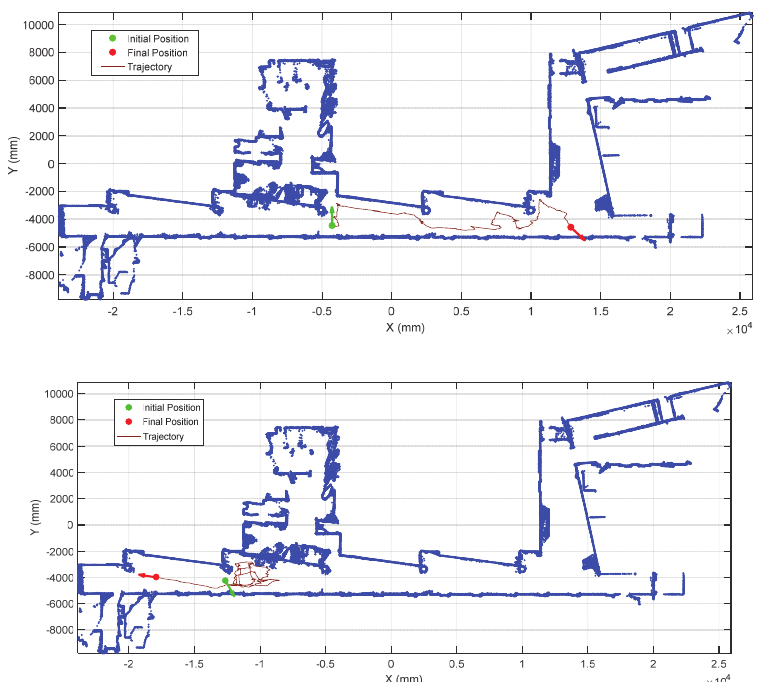
Figure 14. Estimated trajectory of the mobile robot with the 2D LIDAR tilted down 25 ◦ for the cases shown in Figure 12: (top) right side of the corridor and (down) left side of the corridor.